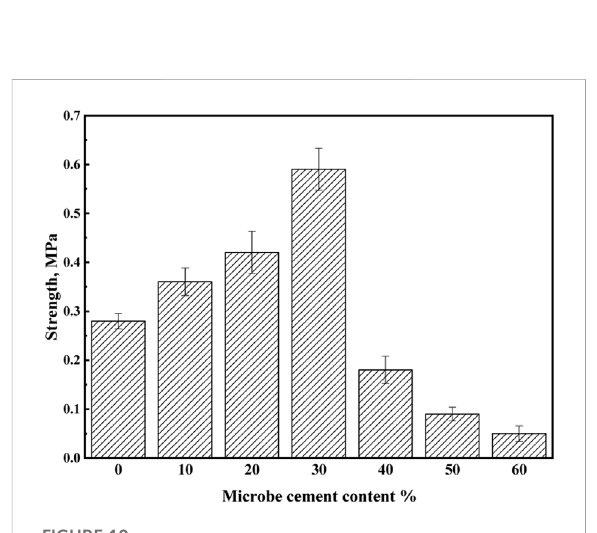
FIGURE 10 Compressive strength of different solidi fi cation products. FIGURE 11